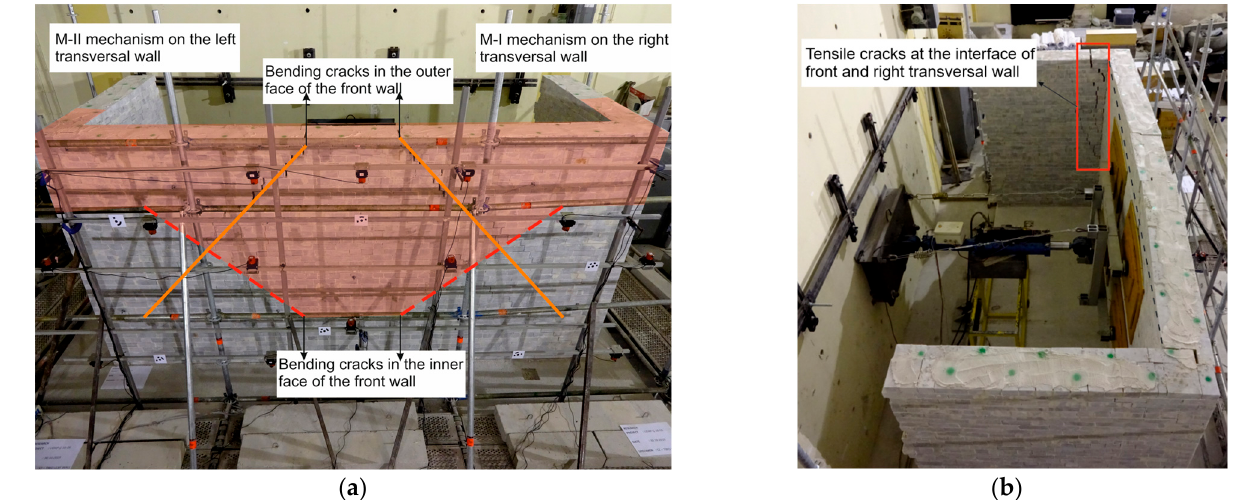
Figure 6. Observed damage in the DMW specimen (a) inner and outer face bending cracks on the front wall (dashed and continuous lines, respectively) and (b) tensile cracks (within the rectangle).